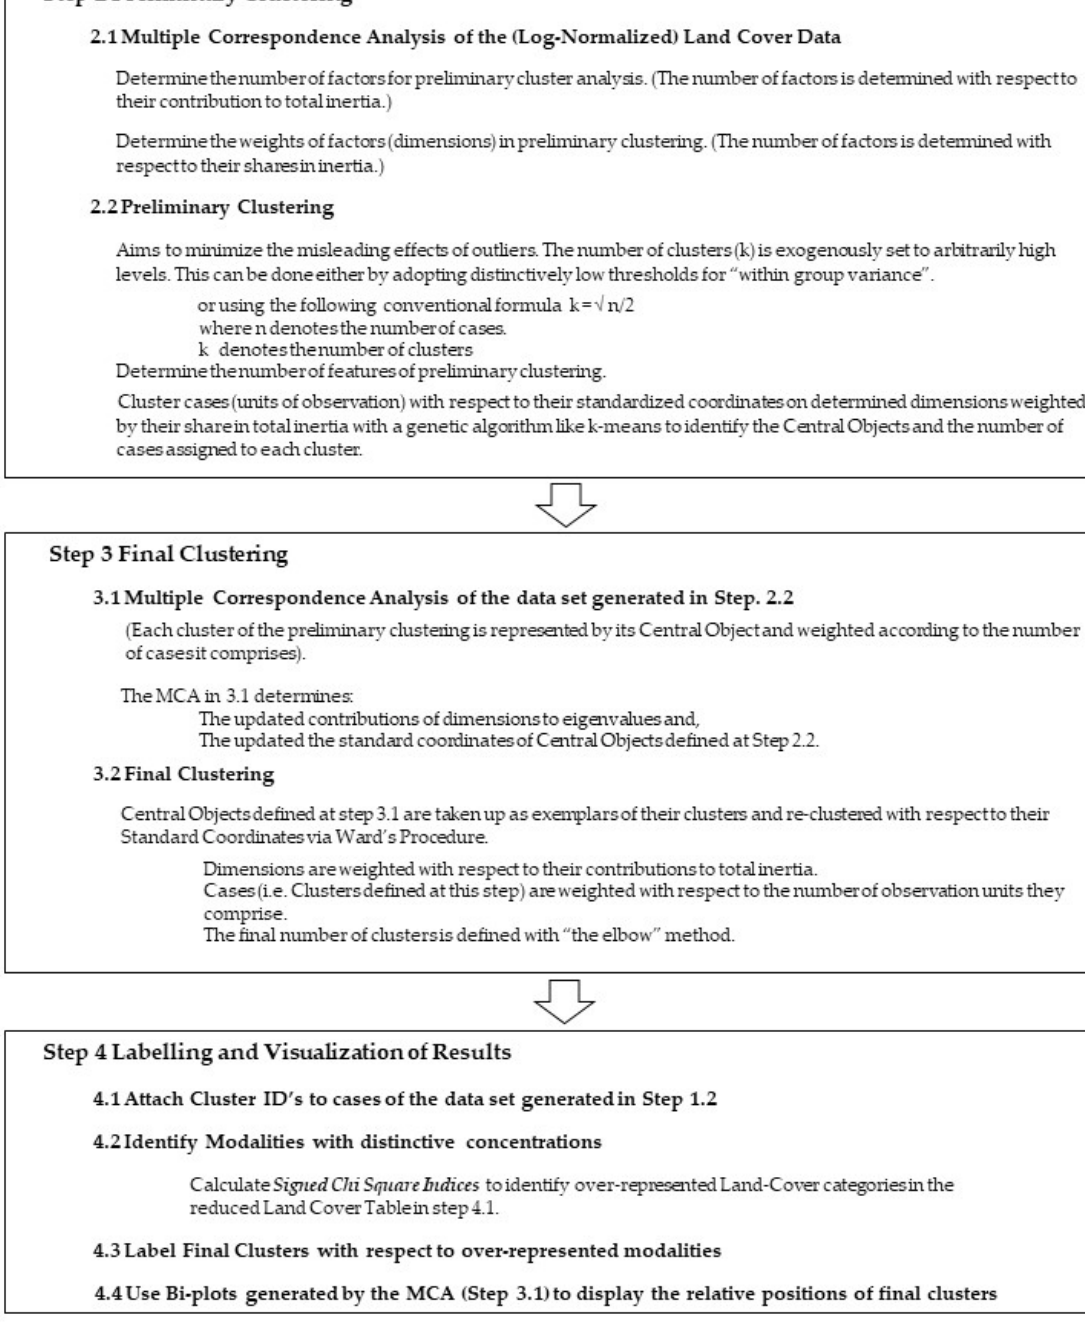
Figure 3. Research flowchart: A summary of the analytical procedure, adopted from Lebart’s model [28]. The last step (Step 4, Figure 3) comprises the labelling and visualization of results. The concentration of land cover types for each map is depicted through contingency tables (Appendix C) in which the over-represented land cover types are identified through